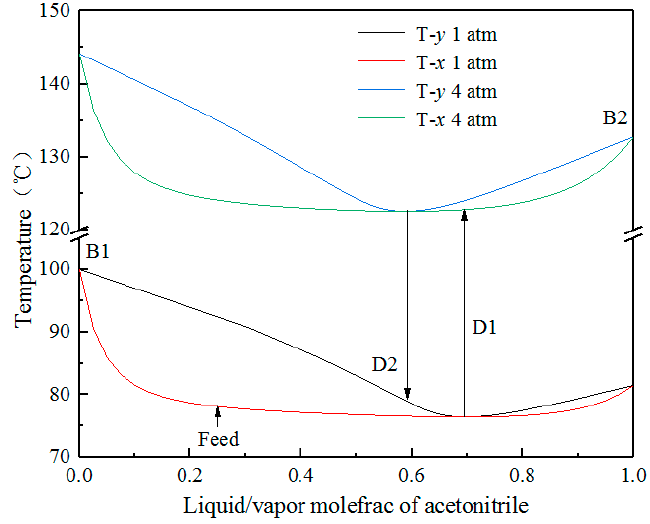
Figure 1. Txy phase diagram for the acetonitrile–water mixture.